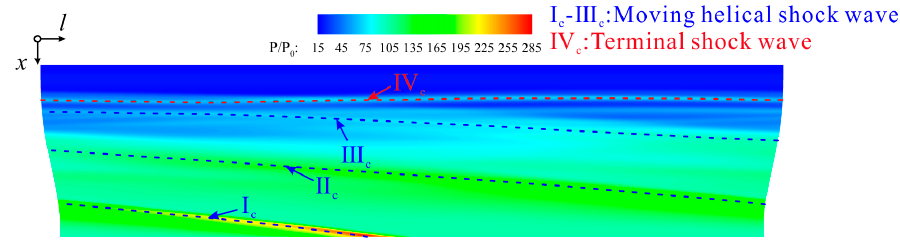
Figure 20. Shock wave structure on the central plane at t = n T in x - l plane, where l denotes the arc length, and the dependent ratio of x and l equals 1.